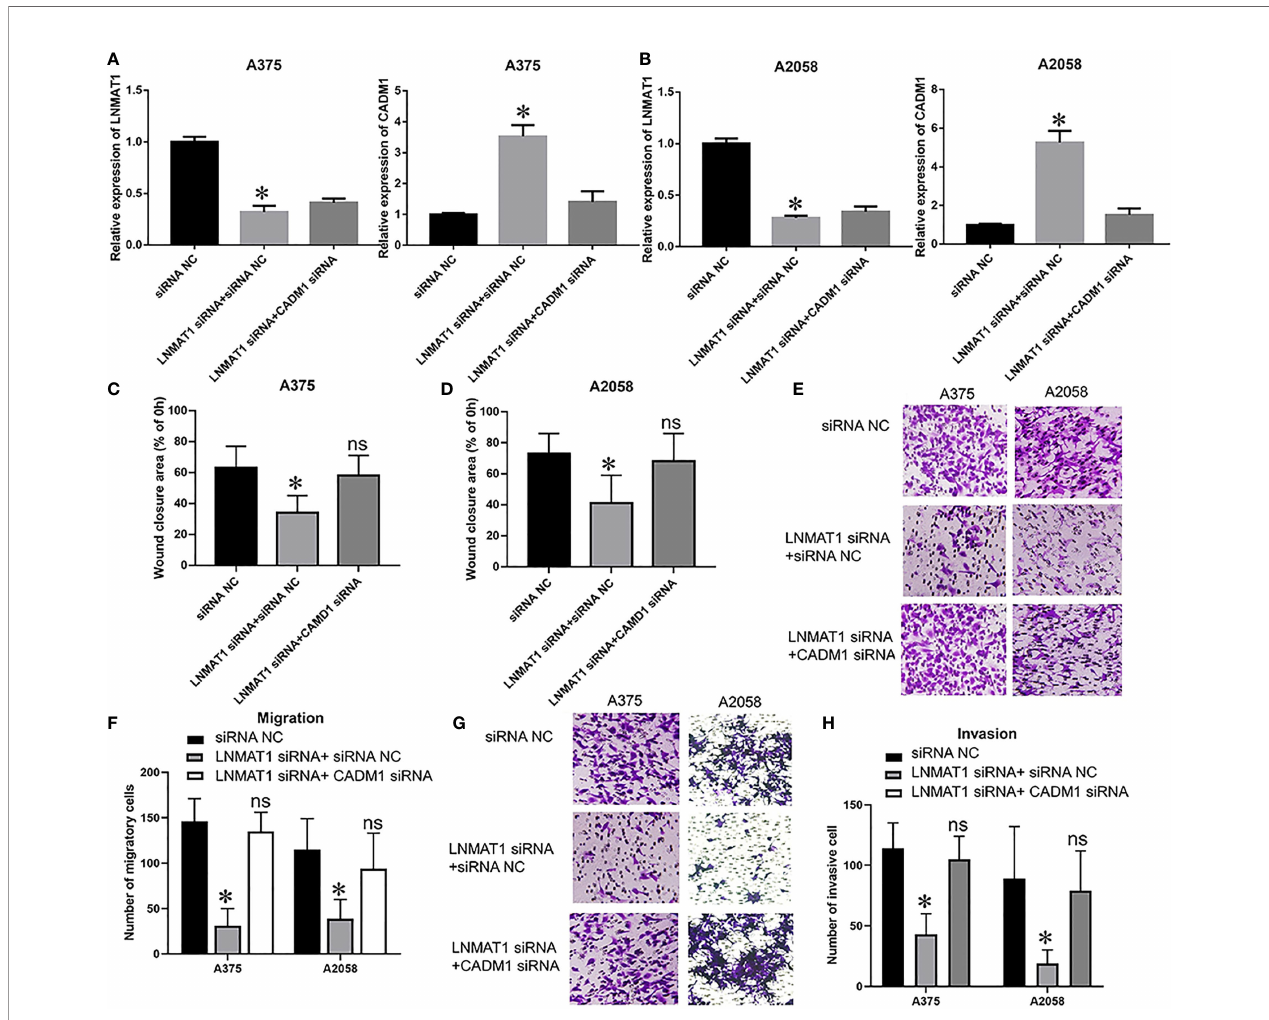
FIGURE 4 | CADM1 mediates the function of LNMAT1 in MM cells. MM cells were transfected with siRNA NC, LNMAT1 siRNA + siRNA NC, or LNMAT1 siRNA + CADM1 siRNA. (A, B) LNMAT1 and CADM1 mRNA expression levels in A375 (A) and A2058 (B) cells of the indicated groups; (C, D) . Wound healing assays were used to determine the migratory distances of A375 (C) and A2058 (D) cells in the indicated groups; (E, F) Transwell assays were used to determine the number of migratory A375 (E) and A2058 (F) cells in the indicated groups; (G, H) Transwell assays were used to determine the number of invasive A375 (G) and A2058 (H) cells in the indicated groups. Data are shown as the mean ± S.E. *P < 0.05, ns, not signi fi cant. The representative results of three independent experiments are